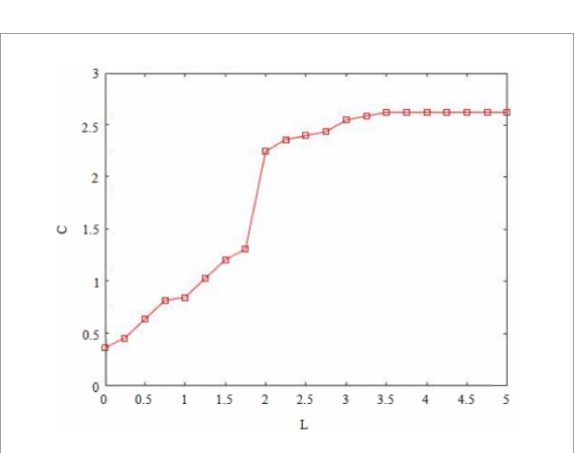
FIGURE2 Differential leadership and the psychological capital of “insider subordinates.”